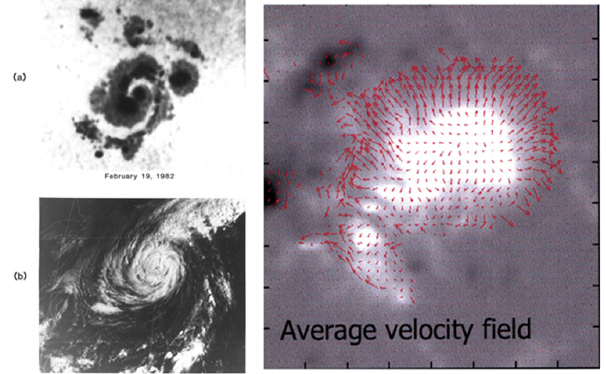
Fig. 4b. Upper left: a sunspot with a vortex structure; lower left, a typhoon near Japan; right: the Evershed flow.